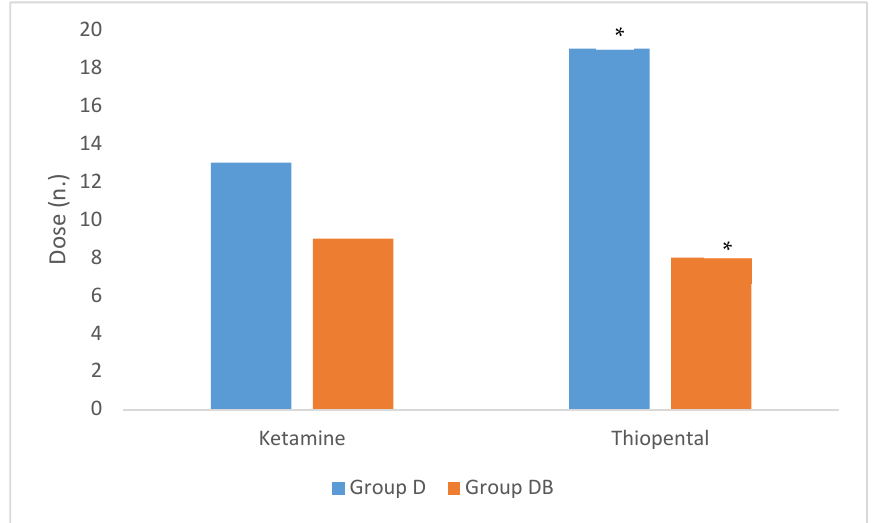
Figure 4. Total number of additional doses of ketamine and thiopental required to deepen anaesthesia in donkeys undergoing castration, randomized to receive an intravenous premedication with detomidine (Group D, n.8) or detomidine -butorphanol (Group DB, n.10). Asterisks (*) indicate the level of significance set at p < 0.05. The recovery score was good (score 1) in all donkeys. reflex were compared between groups at Ts, Tt, Tl Te for each testicle, but no statistical differences were found ( p > 0.05). Looking at the time after the surgical stimulations, statistical differences were found 90–120 s after the stimulation itself. When each variable was analyzed for significative differences within each group, only muscle relaxation was significantly higher in Group D at T14 compared to T22-T28 (Figure 5) ( p = 0.03).